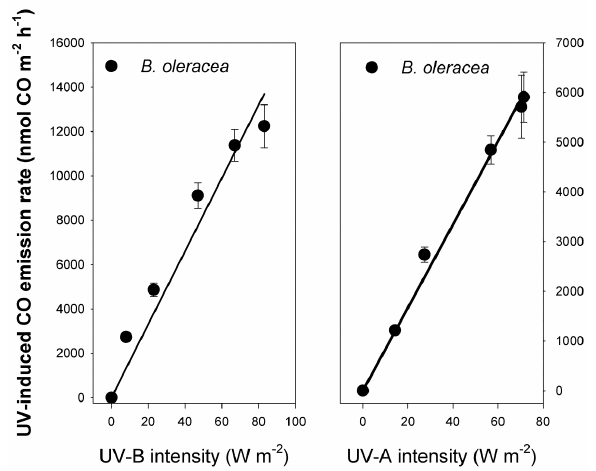
355 Fig. 3. The UV-irradiance response of CO emissions by leaf 356 (mean ± S.E. of ER light – ER dark ) at 25 ◦ C. The lines indicate the position of the linear regression lines intercepting at (0, 0) and slopes of 160 and 89 for B. oleracea (UV-B) and B. oleracea (UV- A), respectively. The regression coefficients ( R 2 ) are 0.96 and 0.98,